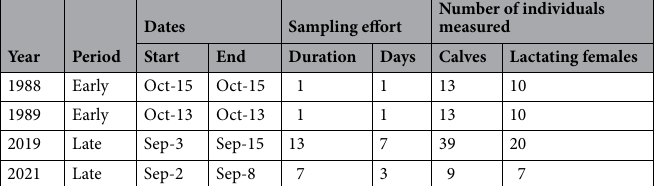
Table 1. Composition of the southern right whales sampled in South Africa by aerial photogrammetry by year and reproductive class. N = 121 measured whales.